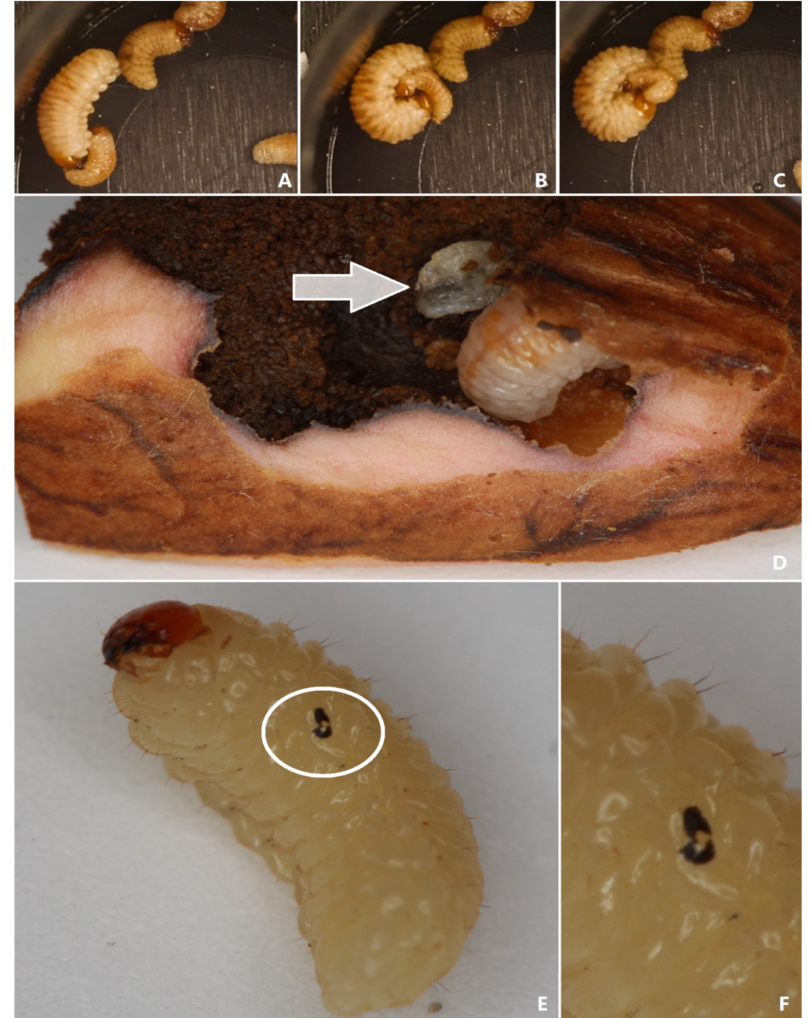
Figure 5. Aggressive behavior of C. glandium larvae: ( A – C )—subsequent stages of an attack; ( D )—dead, partly eaten larva (marked with an arrow) and well-fed, living one; ( E )—scar on the body of a fully developed larva; ( F )—close-up of the mouthpart-shaped